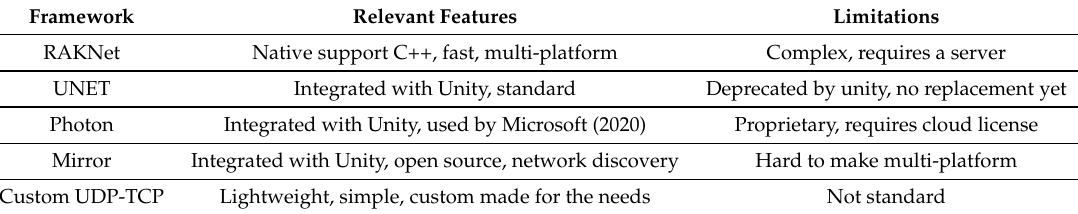
Table 1. Comparison of the different frameworks considered for the implemented system.